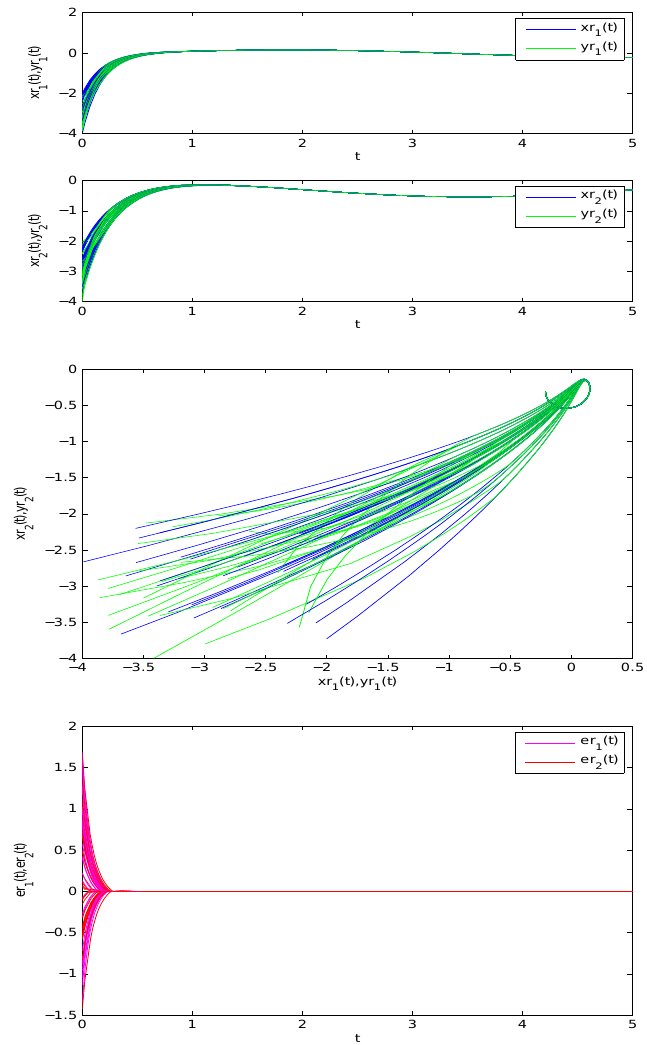
Figure 5. Instantaneous error states for the R part between for the variable ˘ x of (18) and ˘ y of (19) under 30 random initial values for fixed-time